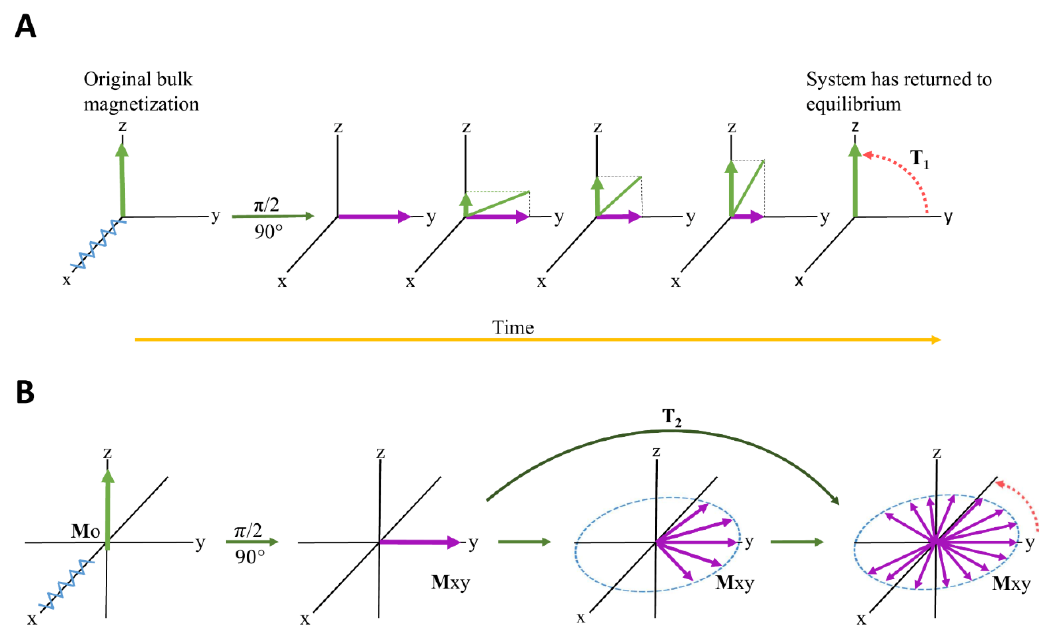
Figure 4. RF (radiofrequency) pulse causes the bulk magnetization to move to the transverse plane. Over time (ms to seconds, and in extreme cases, minutes [155]), the bulk magnetization will decrease in the transverse plane, and increase in the longitudinal axis, returning to its original, equilibrium value. ( A ) represents T 1 relaxation and ( B ) represents T 2 relaxation.